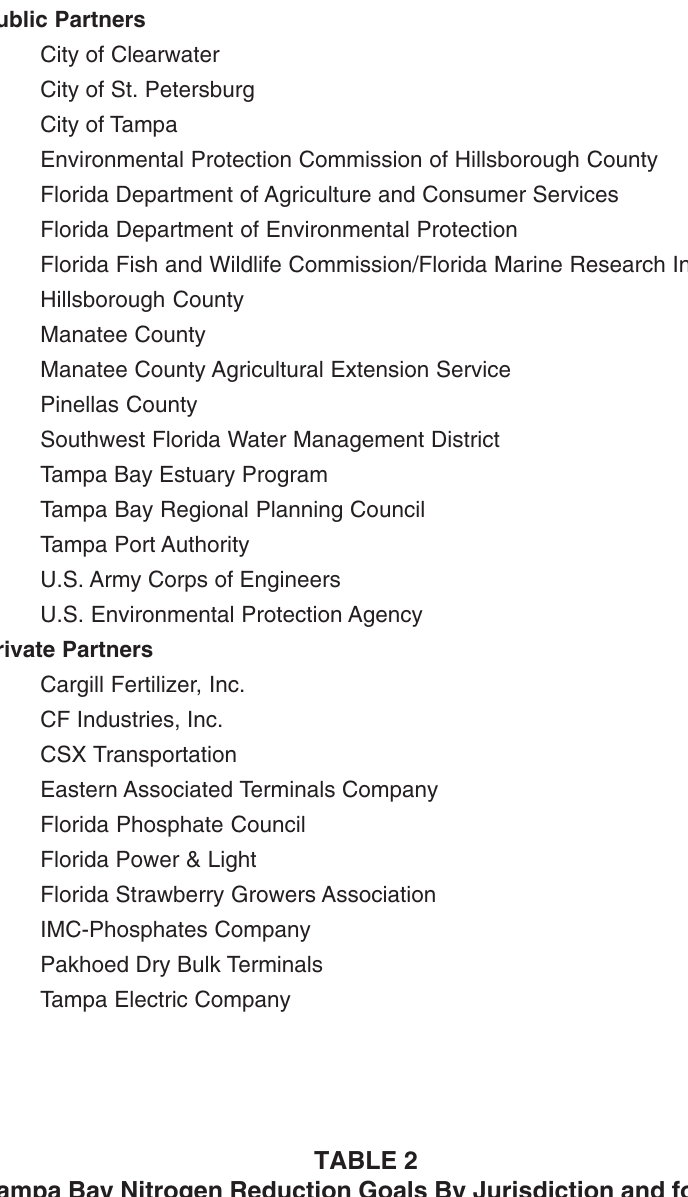
Tampa Bay Nitrogen Reduction Goals By Jurisdiction and for